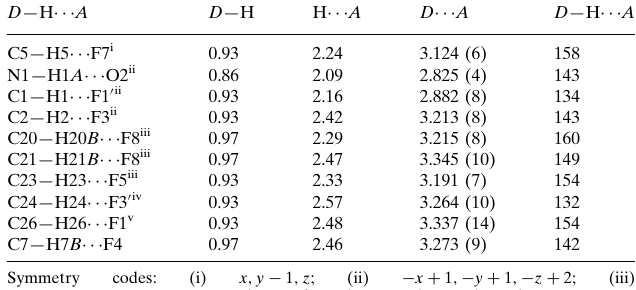
Bruker SMART CCD area-detector diffractometer Absorption correction: none 17389 measured reflections